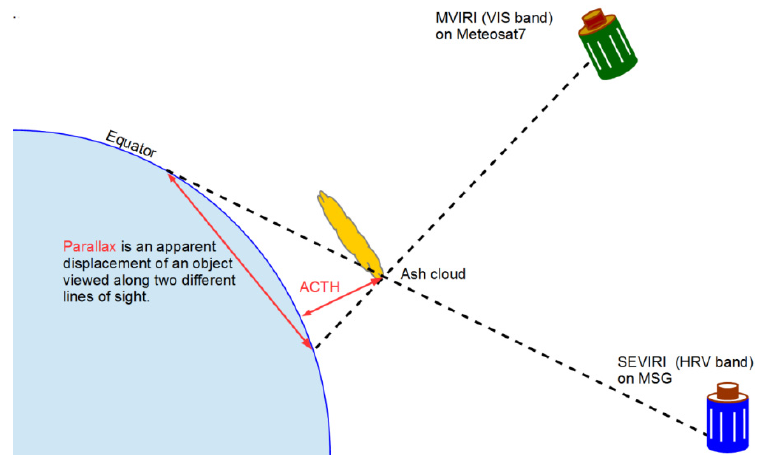
Figure 1. The scheme of observations as seen by an observer above the North pole; the lines of sight from two satellites cross at one point. Its coordinates are easy to determine within the Cartesian geocentric coordinates system. Conversion to geodetic coordinates gives us